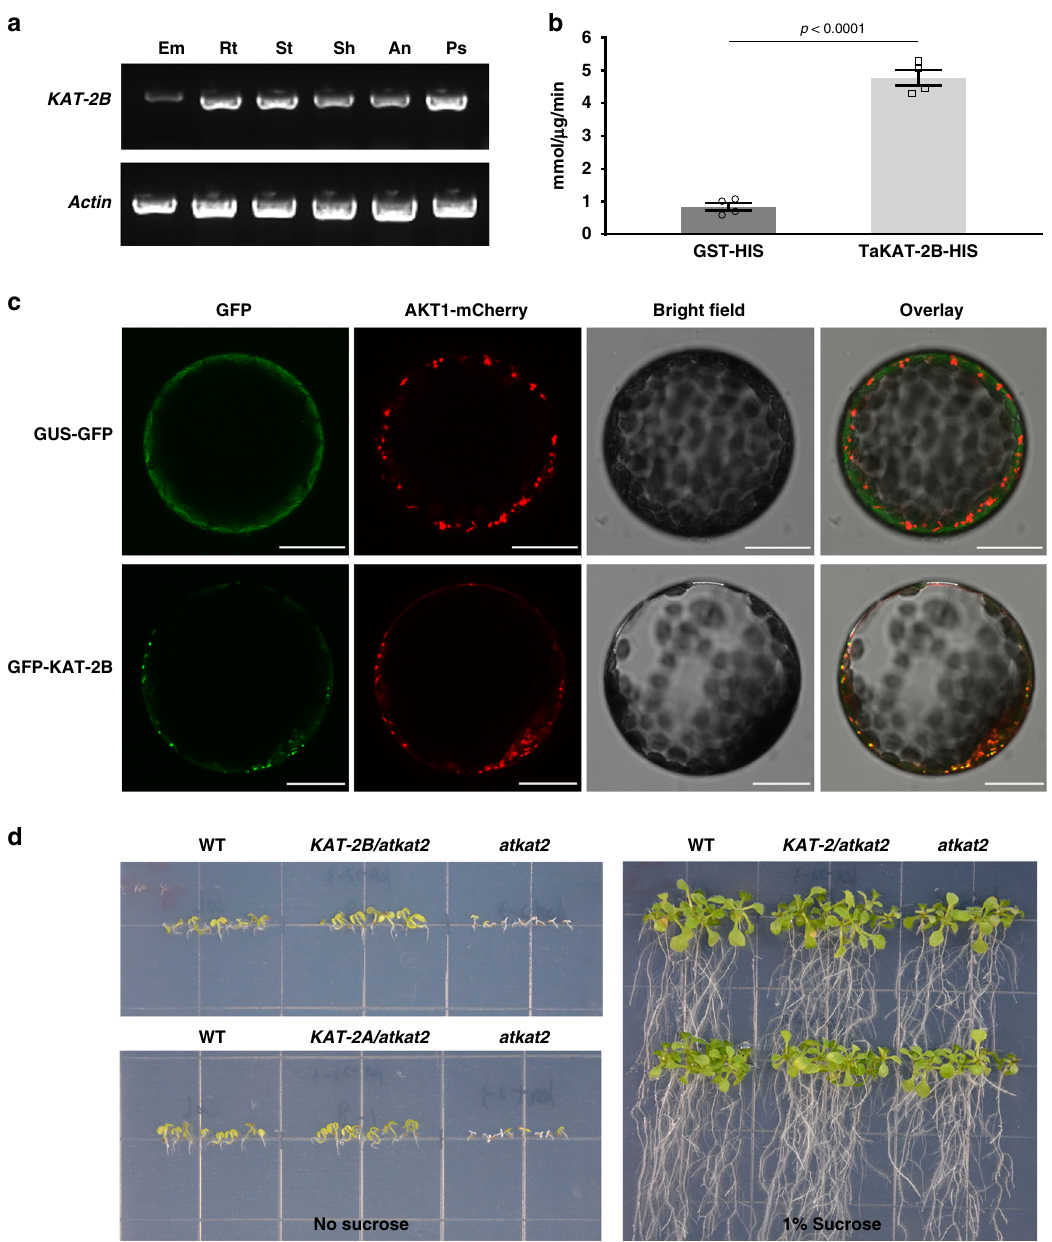
Fig. 4 KAT-2B is an active thiolase in the peroxisome. a RT-PCR analysis of KAT-2B in six tissues of WT. b Speci fi c biochemical activity of recombinant KAT-2B. n = 4. Data are represented as mean ± SEM, and p values are indicated by two-tailed unpaired t test. c Subcellular localization of GFP-KAT-2B fusion protein in protoplast. Images are representative of three independent experiments. GUS-GFP stands for a soluble protein. AKT1-mCherry is a peroxisome marker. Scale bar = 25 μ m. d Rescue of the Arabidopsis kat2 mutant in a sucrose-free medium by wheat KAT-2 transgene. Note that Arabidopsis kat2 mutant is lethal in a sucrose-free medium. Each grid represents 1 cm 2 on the plate. Source data underlying Fig. 4a – c are provided as a Source Data fi